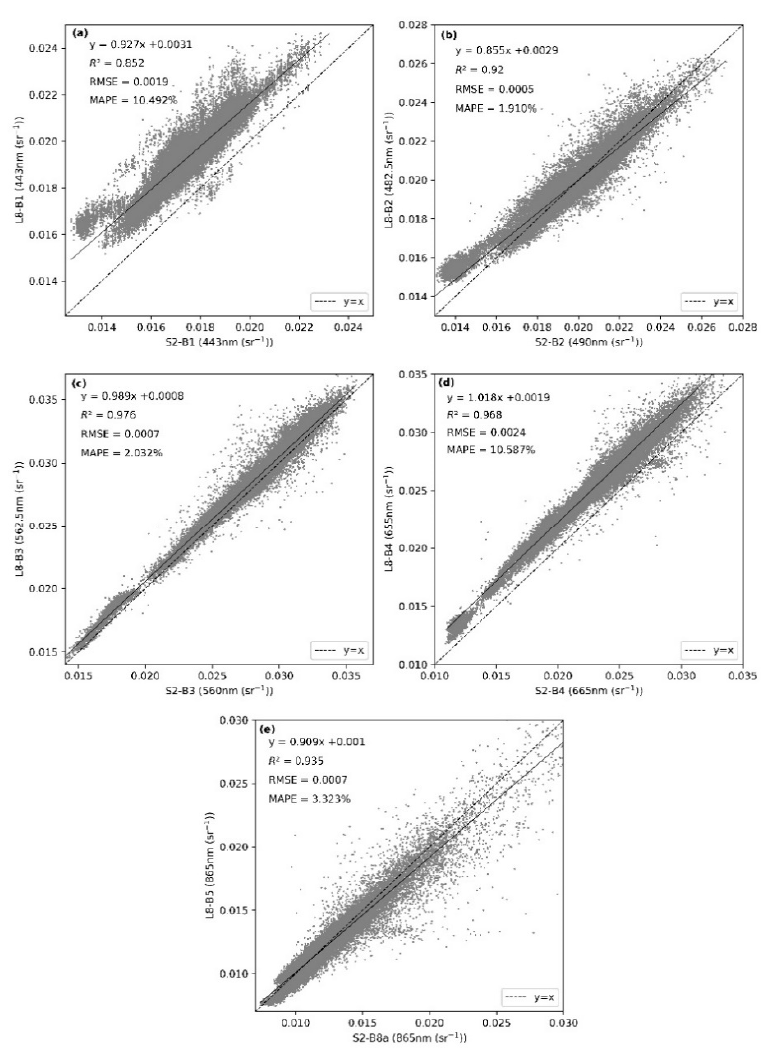
Figure 2. Consistency of the remote sensing reflectance (Rrs) values derived from MSI and OLI images in Shengjin Lake. ( a ) Coastal blue band, ( b ) Blue band, ( c ) Green band, ( d ) Red band, ( e ) Near-infrared band.